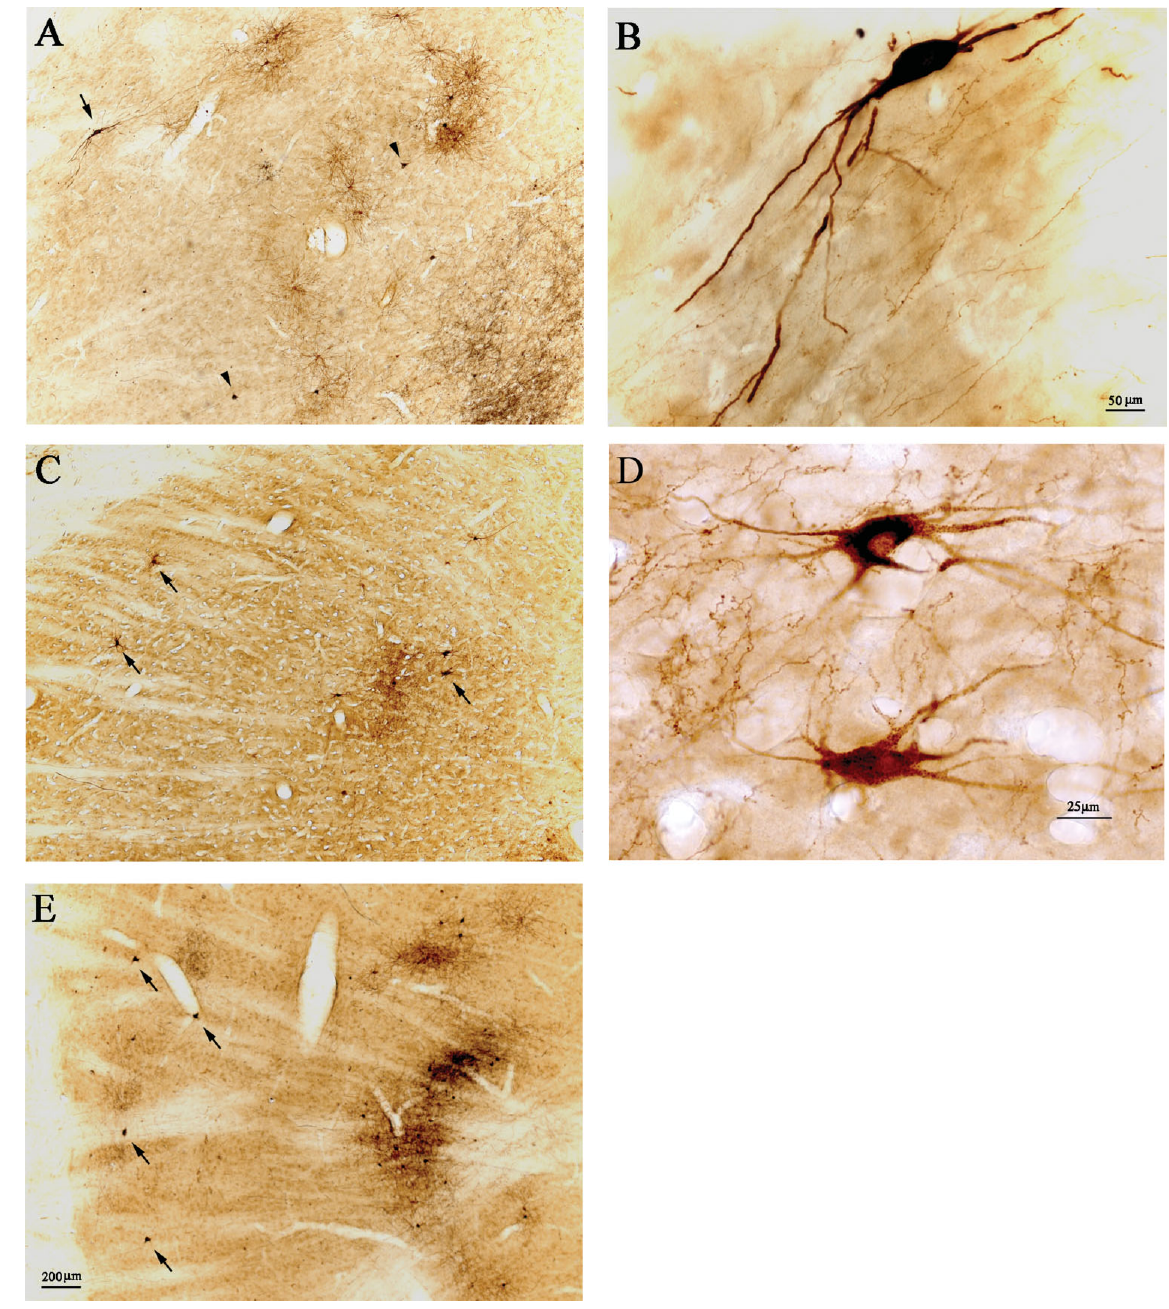
Figure 2. Retrogradely labeled pulvinocortical neurons include giant cells . ( A ) Injections of AdSynEGFP (brown DAB) and BDA (black, nickel-enhanced DAB) in posterior area TE (TEp) result in a dense projection focus in Plil, dorsal to the corticotectal tract. Abundant EGFP-labeled neurons (brown) are evident, with some BDA retrogradely labeled neurons (black), and abundant BDA anterogradely labeled terminations (black). Arrowheads point to two giant BDA-labeled neurons, and arrow indicates one giant EGFP-expressing neuron. Dorsal is at the top and lateral is to the left (also for C and E). ( B ) Higher magnification of the EGFP-expressing neuron in A. ( C ) After injections in posterior TE, in case 57, of FR (brown DAB) and BDA (black, nickel-enhanced DAB), there is a dense projection focus. Two FR-labeled neurons at the lateral edge are indicated by arrows; and a third arrow marks another two giant neurons, located more medially, neighboring to a patch of cortical terminations. ( D ) Higher magnification of the two medially located neurons in C. The upper of these is double-labeled (brown FR and black BDA). ( E ) Injections of AdSynEGFP (brown DAB) and BDA (black, nickel-enhanced DAB) in area V4 (case 109) result in a dense projection focus (and see Figure 3 ). Abundant EGFP-expressing neurons (brown) are evident, with some BDA retrogradely labeled neurons (black) and abundant BDA anterogradely labeled terminations (black). Arrows indicate four relatively solitary giant BDA-labeled neurons, at the lateral edge of the pulvinar. A, C, and E are at the same